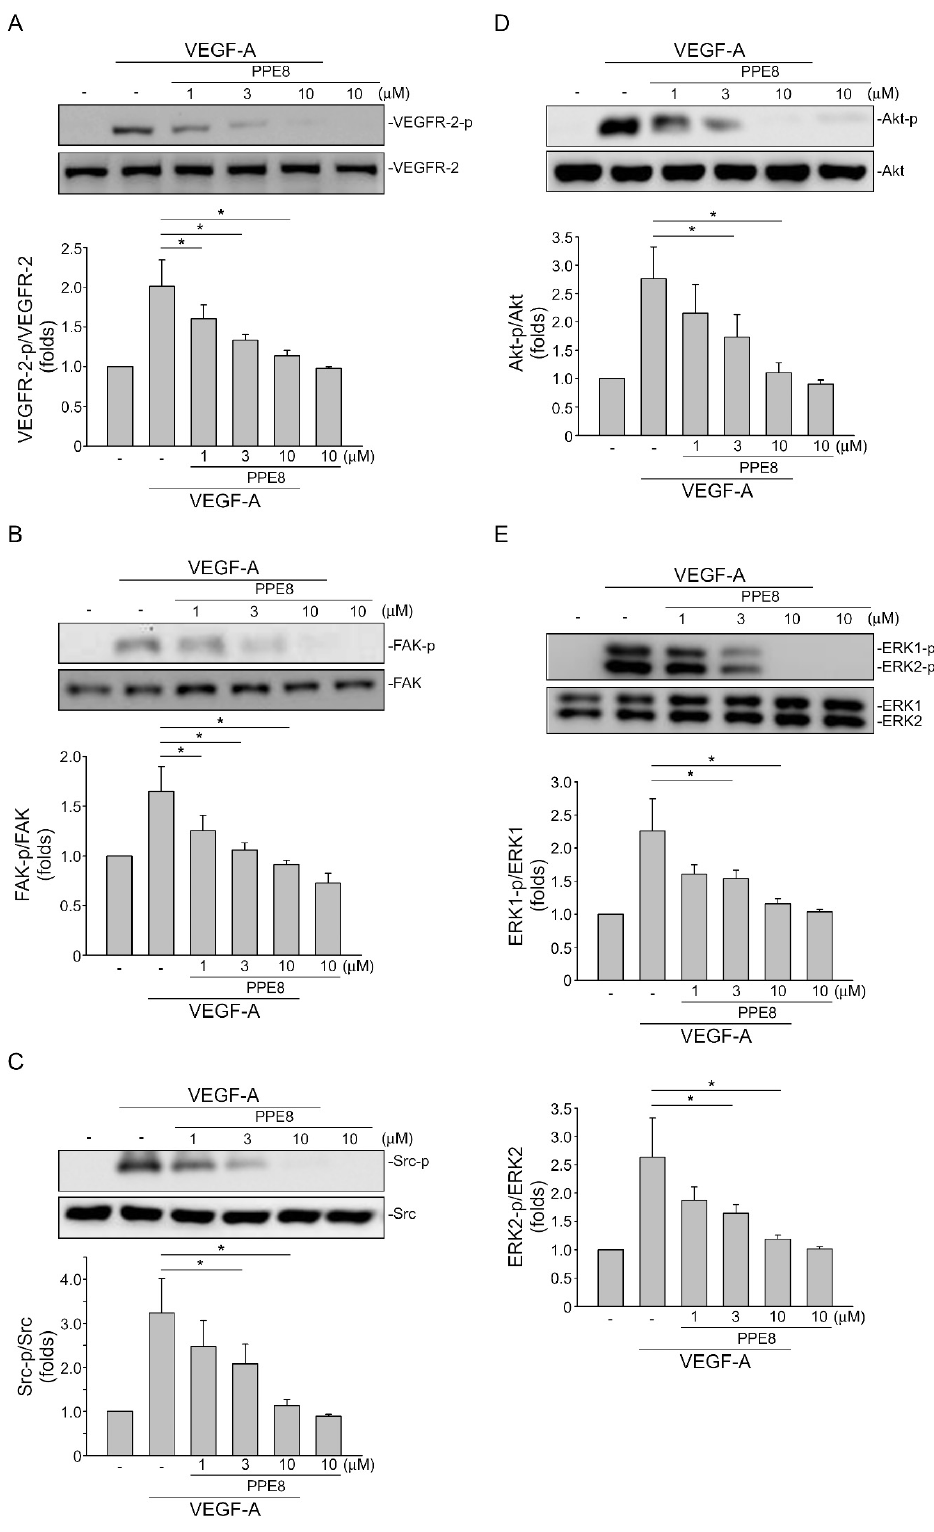
Figure 4. PPE8 inhibited endothelial VEGF-A–VEGFR-2 signaling. After 30 min treatment of